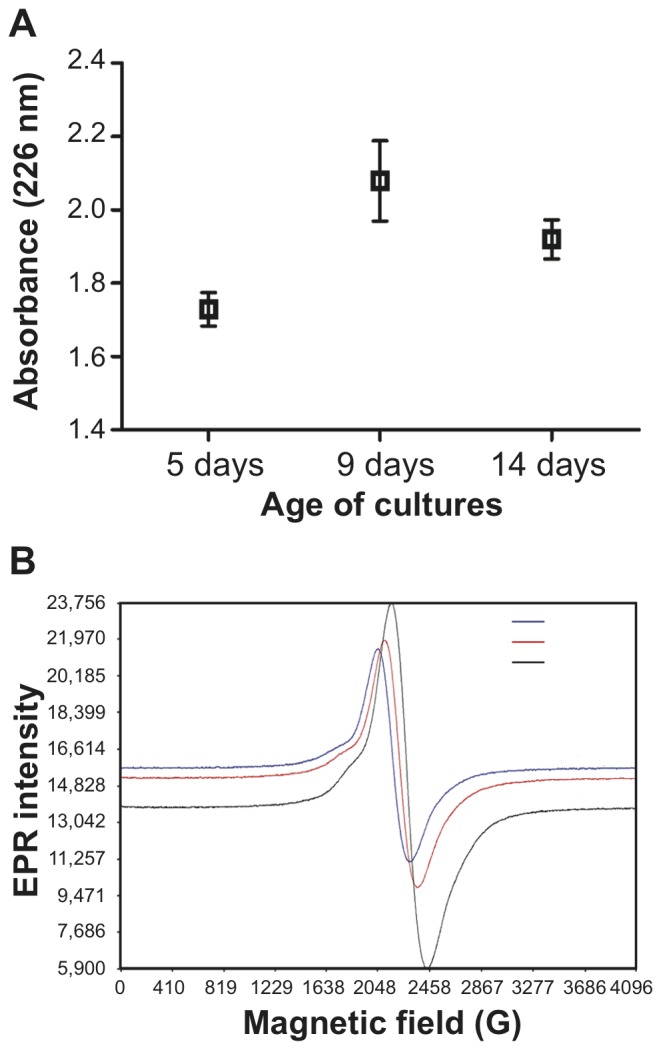
Changes in melanin amount in conidia as the age of culture progresses.Melanin amount in the conidial wall changed with the age of culture as revealed by UV-visible spectrophotometry (A) or electron paramagnetic resonance (B). (A) The mean rank of the quantity of melanin extracted from conidia was significantly different among cultures of different age (p<0.05). (B) EPR spectra of P. boydii conidia taken from cultures of different age (5, 9 and 14 days). The spectra were recorded at a microwave power of 30 db. Spectra are representative of three independent experiments.